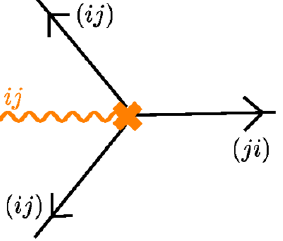
Figure 1. Local structure of BPS trajectories near an ij -branch point.